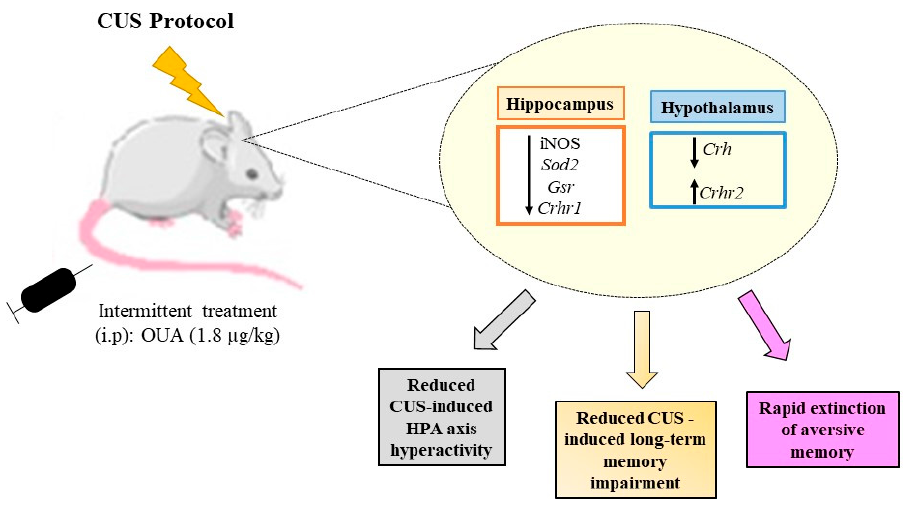
Figure 9. Schematic drawing of the proposed action upon OUA treatment in rats subjected to chronic unpredictable stress. Intermittent treatment with OUA reduced the activity of the HPA axis, since it reduced the expression of Crf and its Crfr1 receptor, leading to a reduction in the serum release of glucocorticoids, in addition, ouabain reduced activity of iNOS enzyme. The interference of treatment with OUA on the HPA axis promoted a rapid extinction of memory due to the fear of animals subjected to chronic stress.